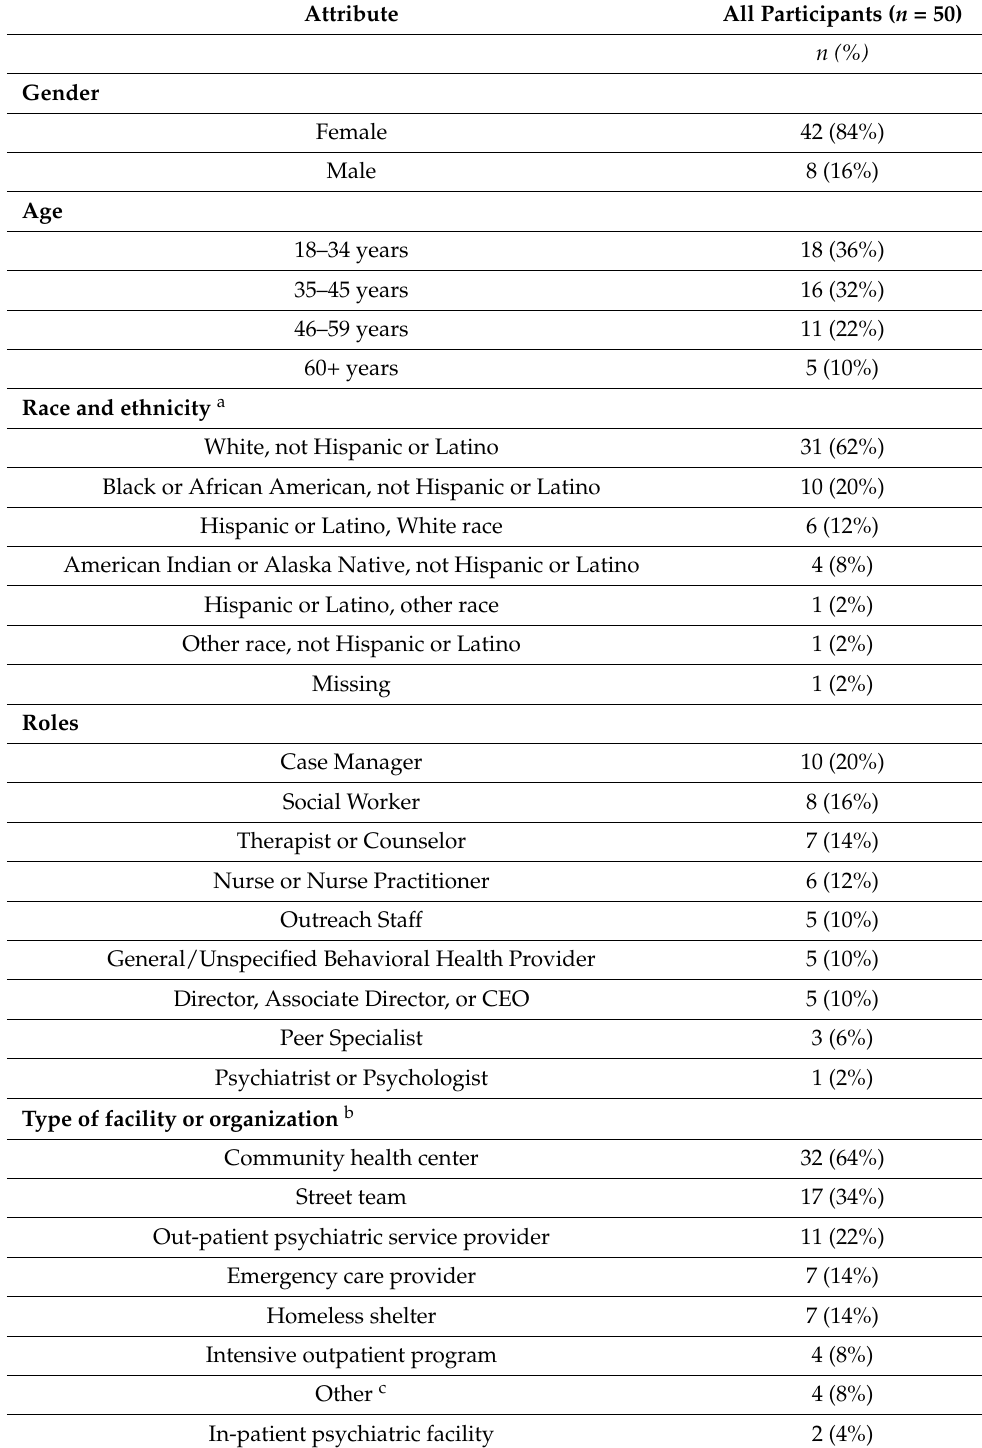
Table 1. Behavioral Health Service Provider Participant Demographics and Clinic